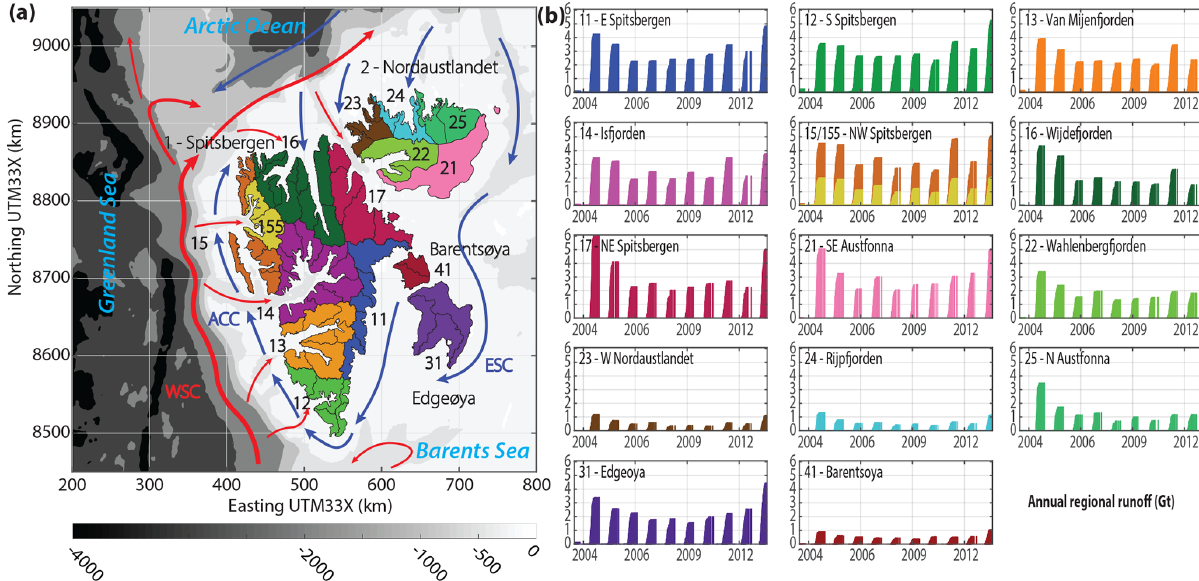
Figure 1. (a) Map of Svalbard with 14 primary hydrological regions (two-digit ID number) and one subregion (155 – Kongsfjorden and 156 – Krossfjorden) shown in different colors. Black outlines indicate secondary hydrological regions. The bathymetry is shown in shades of gray (IBCAO dataset). Adjacent seas and major currents are plotted according to Svendsen et al. (2002) and Hop et al. (2019) in which the red arrows delineates the West Spitsbergen Current (WSC) and pathways of Atlantic Water, and the blue arrows the Arctic Coastal Current (ACC), originating as East Spitsbergen Current (ESC), and other pathways of Arctic Water. (b) Regional time series of annual cumulative glacier runoff extracted from climatic mass-balance simulations by Aas et al.